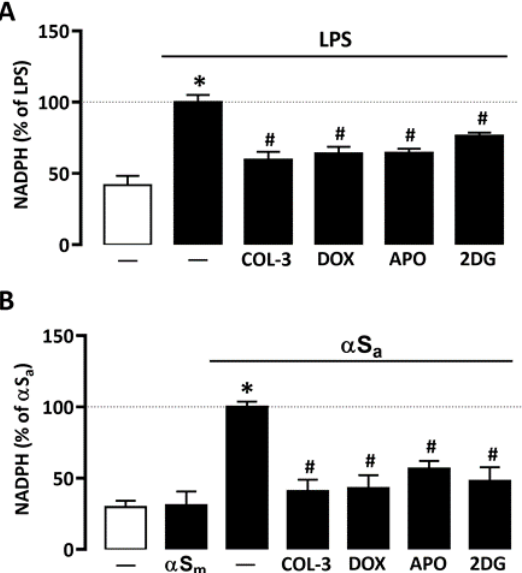
Figure 4. COL-3 prevents NADPH synthesis in microglial cells exposed to either LPS or α Sa. ( A ) Quantification of NADPH in microglial cells exposed or not to LPS (10 ng/mL, 24 h) in the presence or absence of COL-3 (20 µ M), DOX (50 µ M), APO (300 µ M), or 2-DG (500 µ M). ( B ) Quantification of NADPH in microglial cells exposed or not to α Sa (70 µ g/mL, 24 h) in the presence or absence of COL-3 (20 µ M), DOX (50 µ M), APO (300 µ M), or 2-DG (500 µ M). Data are the mean ± SEM ( n = 6–8). * p < 0.05 vs. control; # p < 0.05 vs. corresponding inflammogen. One-way ANOVA followed by Bonferroni post-hoc test.